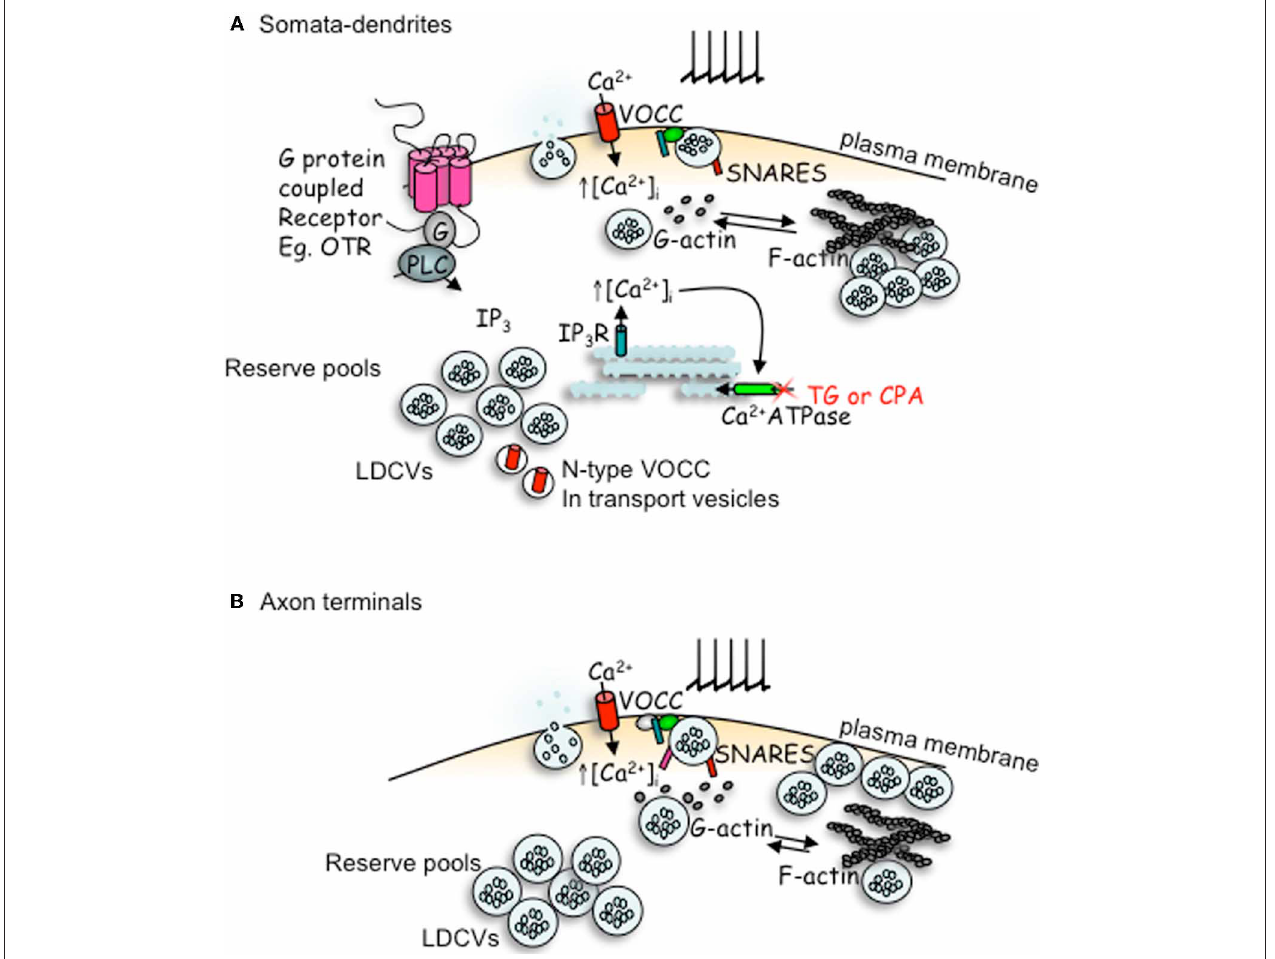
FIGURE 2 | Comparison of peptides release from somata-dendrites (A) and axon terminals (B) of magnocellular neurons. Depolarization induced calcium entry via voltage-operated calcium channels (VOCCs) stimulates peptide release from large dense-cored vesicles (LDCVs). In the somata-dendrites this requires the depolymerization of F-actin to G-actin. The stimulation of G-protein coupled receptors, such as the oxytocin receptor (OTR), stimulates the mobilization of calcium from intracellular stores and an increase in both the number of LDCVs and N-type